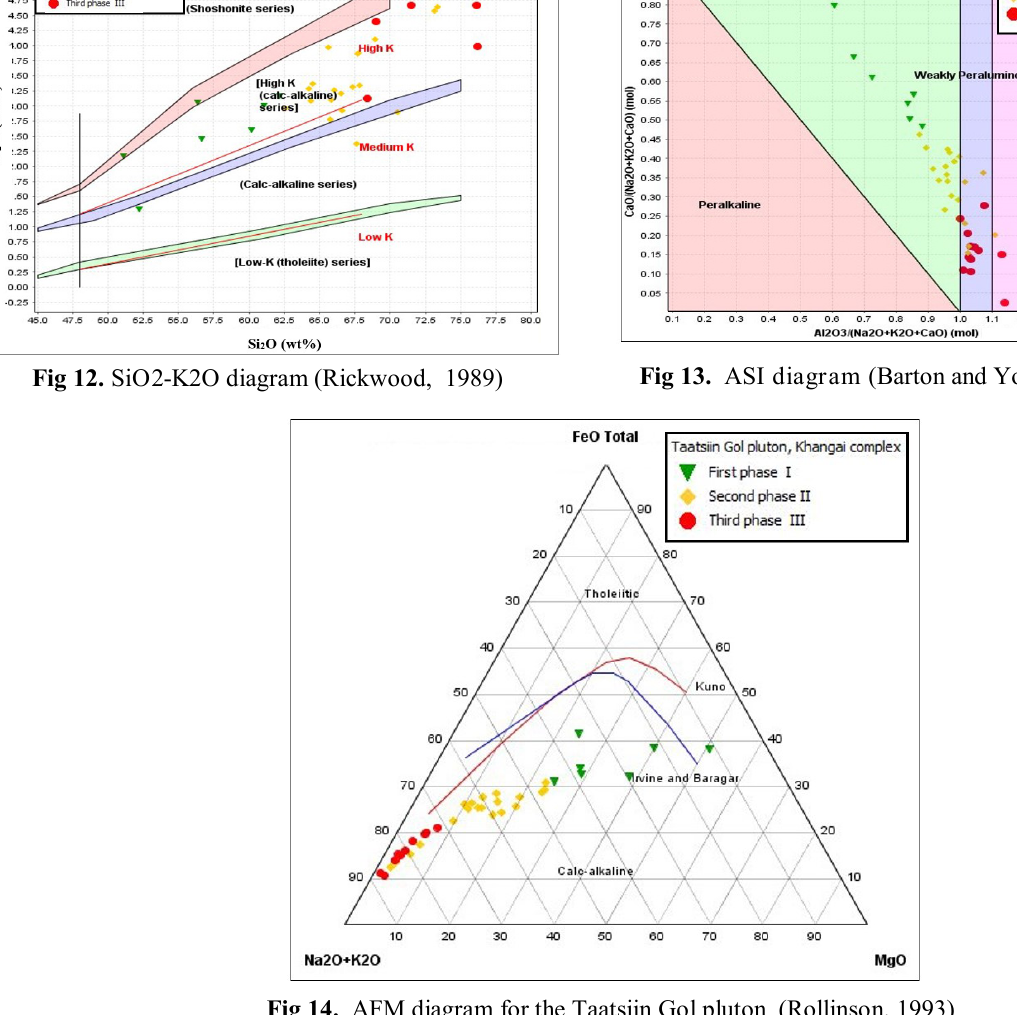
Fig 14. AFM diagram for the Taatsiin Gol pluton (Rollinson. 1993)